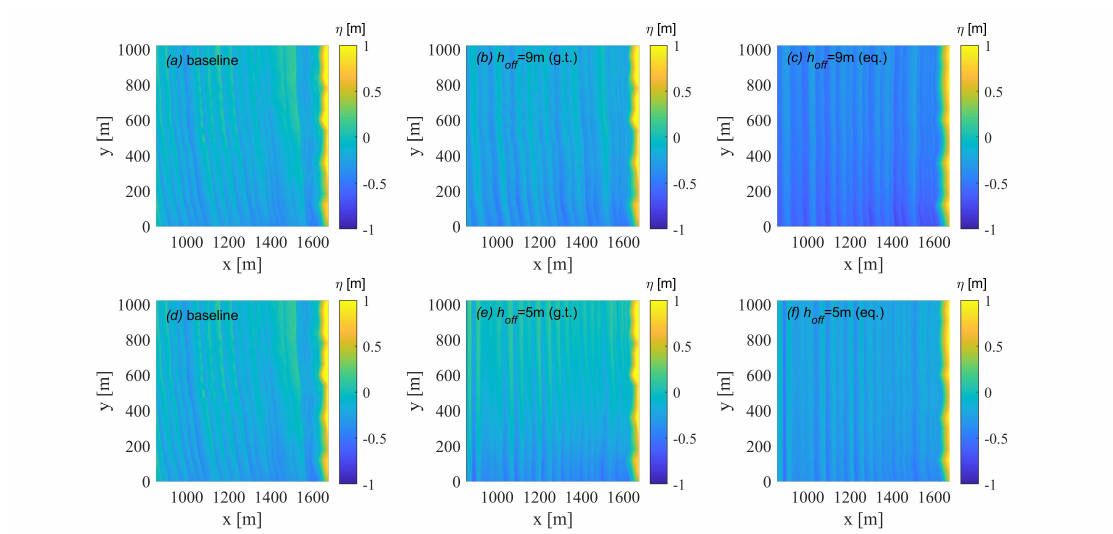
Figure 12. Free-surface level at t = 1000 s ( ∼ 135 waves) for the NNE tests: baseline simulation ( a , d ), flood simulations with boundary condition at h ≈ 9 m ( b , c ) and at h ≈ 5 m ( e , f ). Ground-truth-based ( b , d ) and equilibrium-based ( c , f ) tests.